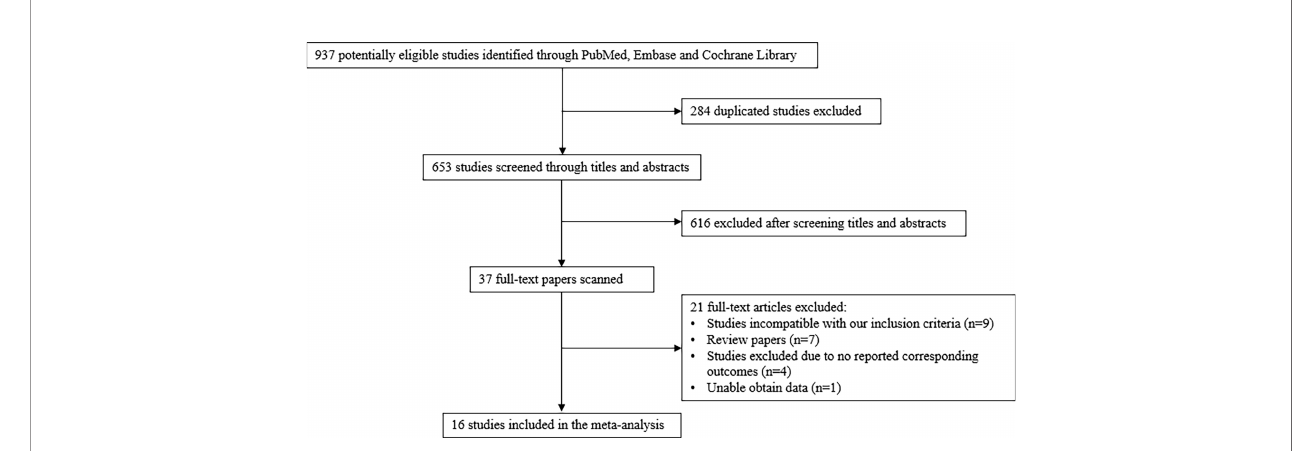
FIGURE 1 | Literature search and